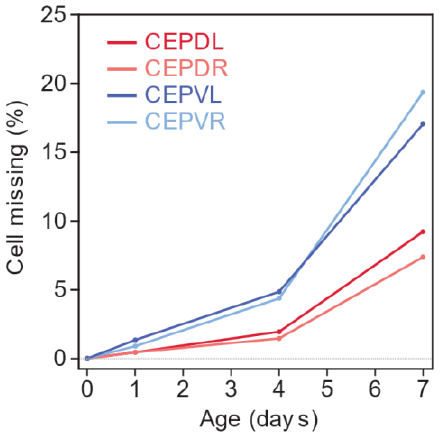
Figure 1. Age-dependent loss of cephalic neurons in animals expressing α-synuclein in the dopaminergic neurons (Parkinson’s disease model). C. elegans has four cephalic (CEP) neurons, located dorsally (D) or ventrally (V), on the left (L) or the right (R) side of the worm. Ordinal logistic regression indicates that the proportion of animals with an absent neuron increases in an age-dependent manner ( p = 0.0009 between days 1 and 4, and p < 0.0001 between days 4 and 7) and that dorsal neurons have a more severe phenotype than ventral neurons ( p < 0.0001), while left-right position has no impact on phenotype ( p > 0.05). Animals that do not express α -synuclein do not exhibit neuronal loss (Table S1, Supplementary Materials). For additional statistics see Table S1, Supplementary Materials.